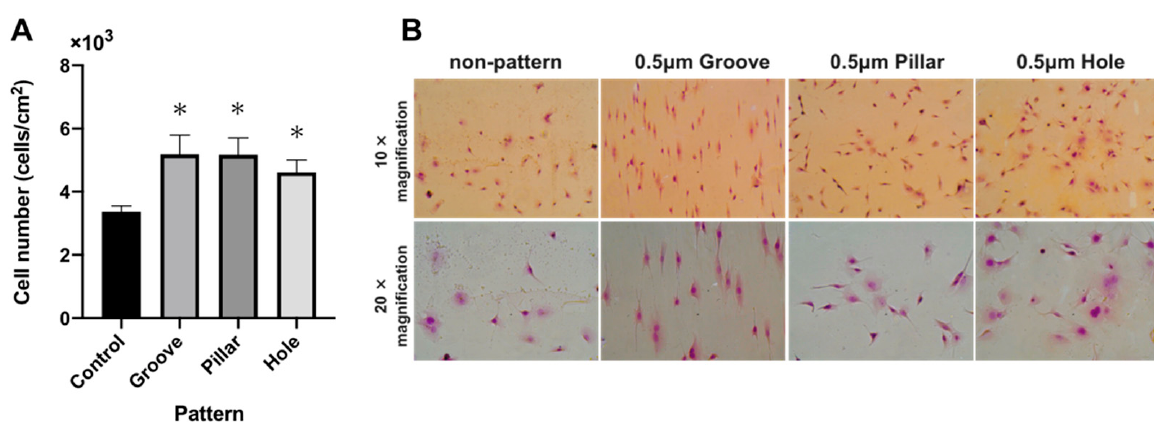
Figure 6. ( A ): The number of MC3T3-E1 cells attached onto the non-patterned (control) and patterned PLGA membranes following 3 h of incubation. ( B ): Light micrographs of MC3T3-E1 cells on non-patterned or patterned PLGA membranes following 3 h of incubation.